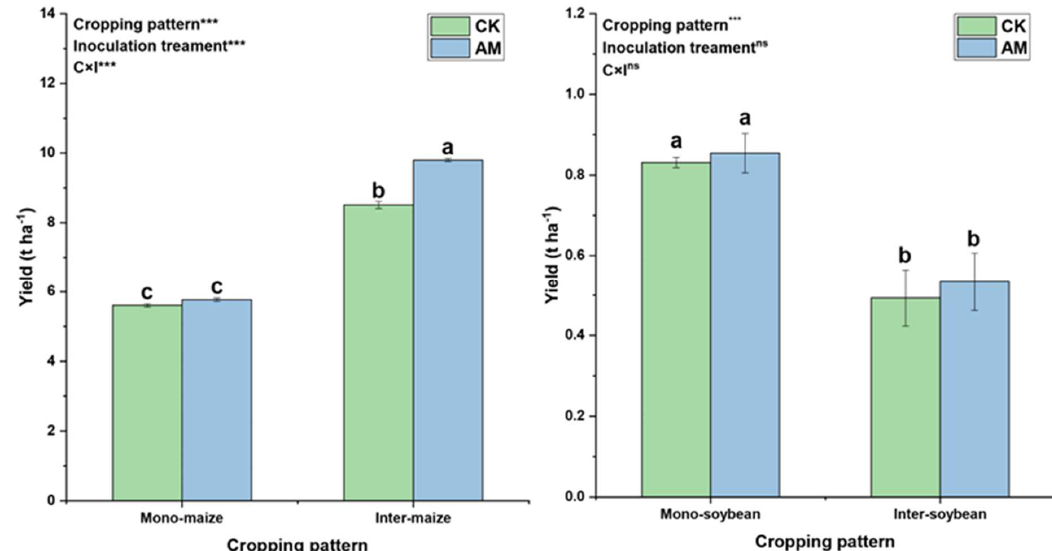
Figure 2. Yield under different cropping patterns and inoculation treatments in the harvesting stage. Mono − and inter − maize were Zea mays L. ‘Chenghai No. 618’ in monocropping and intercropping, mono − and inter − soybean were Glycine max L. ‘Zhonghuang No. 17’ in monocropping and inter- cropping. Standard deviation is shown by the deviation bars. Significantly different are bars followed by lowercase letters ( p < 0.05). ns: p > 0.05, ***: p < 0.001.